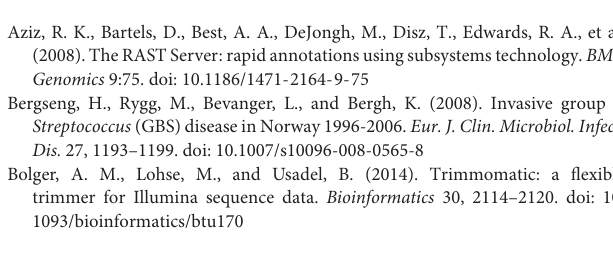
TABLE S1 | Overview of resistance genes and their associated mobile genetic